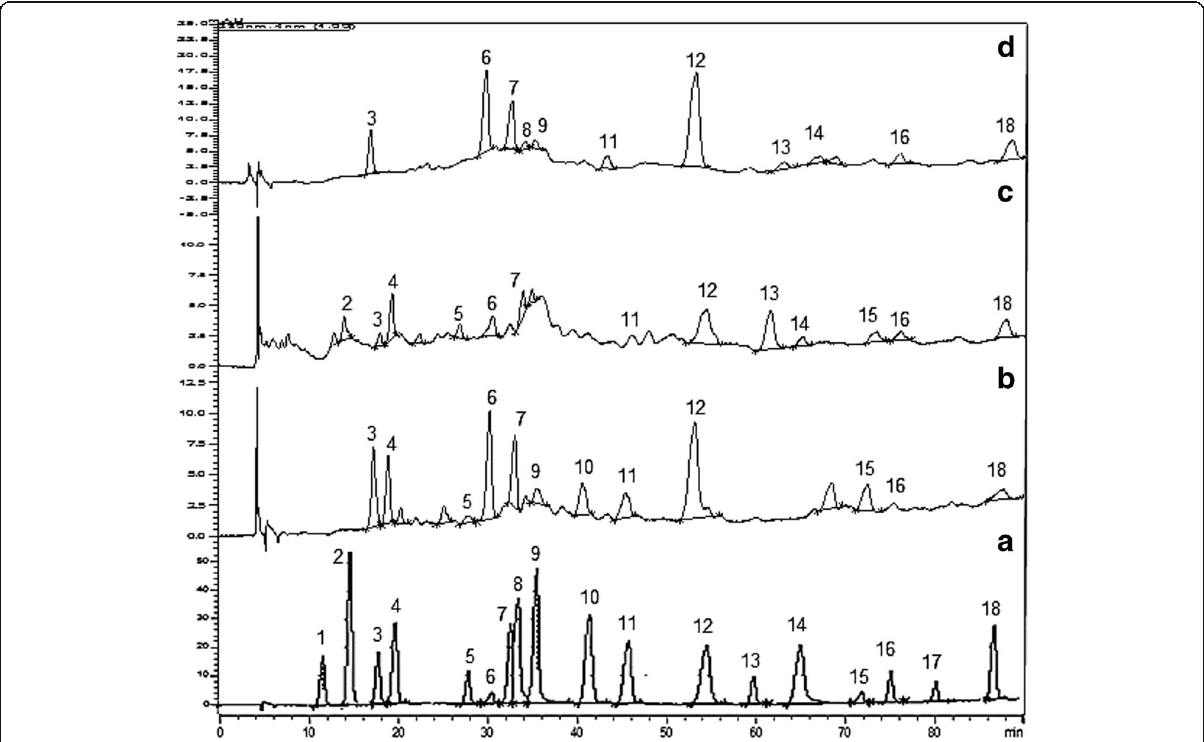
Fig. 3 RP-HPLC chromatograms of standard compounds ( a ) and ethyl acetate ( b ), water ( c ), and methanol ( d ) extracts of Ajuga bracteosa . Individual peaks showing phenolic compounds i.e. Hydroquinone (1), Pyrocatechol (2), Gallic acid (3), Resorcinol (4), Catechin (5), Chlorogenic acid (6), Caffeic acid (7), Vanillic acid (8), p -Coumaric acid (9), Ferulic acid (10), Sinapic acid (11), Coumarin (12), Salicylic acid (13), Trans cinnamic acid (14), Rutin (15), Quercetin (16), Ellagic acid (17) and Kaempferol